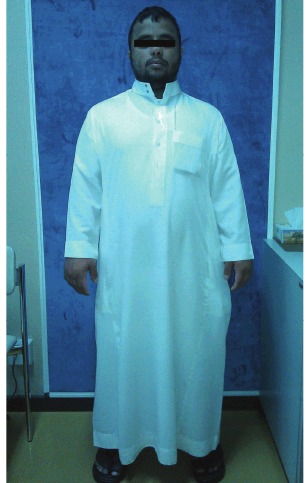
Figure 2: Full body photo of the patient.